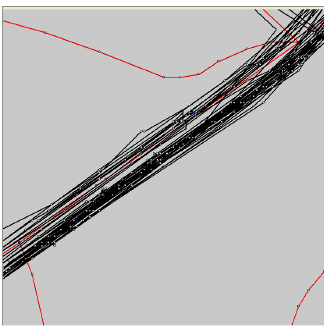
Figure 8. Vehicle track.